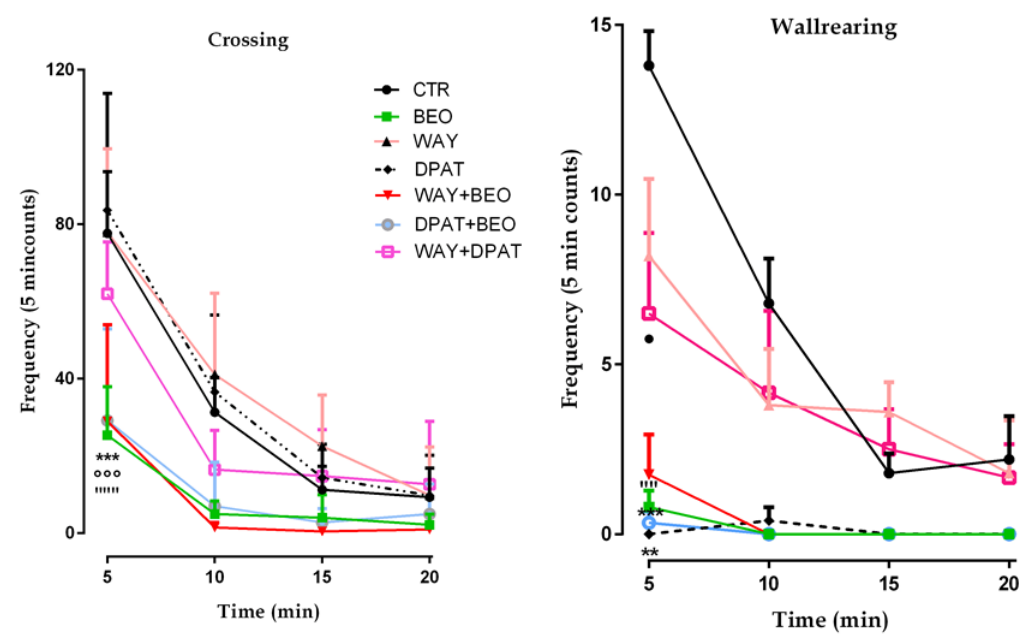
Figure 3. Crossing and Wallrearing frequencies in open field test in male Wistar rats after systemic (i.p.) administration of jojoba oil (CTR) (500 µ L / kg), Bergamot Essential Oil (BEO) (500 µ L / kg), WAY100635 (WAY) (1 mg / kg), 8-OH-DPAT (DPAT) (1 mg / kg), WAY + BEO (1 mg / kg + 500 µ L / kg), DPAT + BEO (1 mg / kg + 500 µ L / kg), and WAY + DPAT (1 mg / kg + 1 mg / kg). Data are expressed as mean ± SEM ( n = 5–6 per group). *** p < 0.001 and ** p < 0.01 vs. control group; ◦◦◦ p < 0.001 vs. BEO group; • p < 0.05 vs. DPTA group; “” p < 0.01 and “”” p < 0.001 vs. WAY group. Statistical analysis